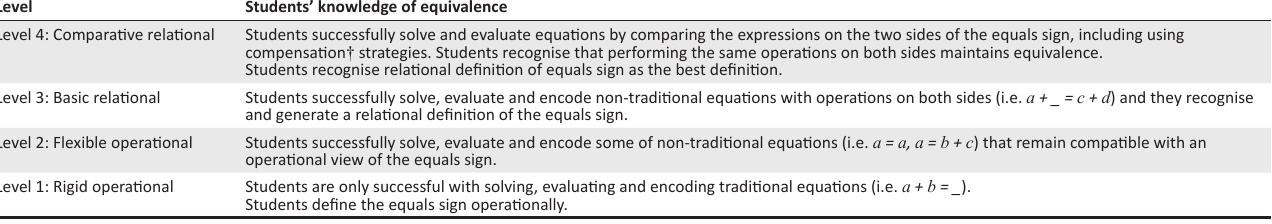
TABLE 1: Construct map for mathematical equivalence